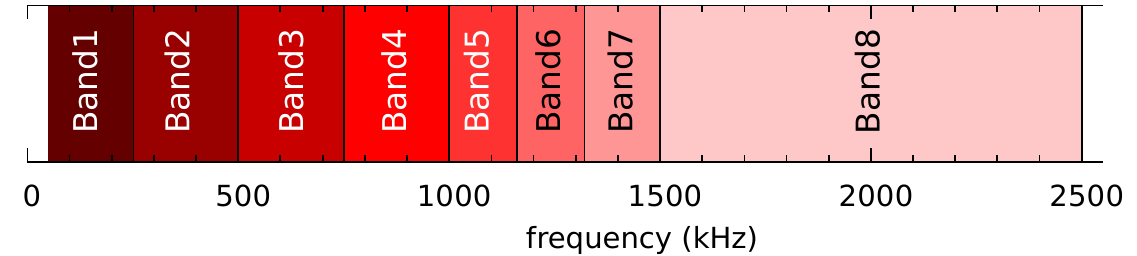
Figure 2. Scanning and generating C-scan images with the laser FF PE UPI system. The pulse laser beam of the laser FF PE UPI system can drive various ultrasound frequencies, and the LDV can divide the ultrasonic waves into several ultrasound bands. In this study, eight narrow bands were used. The 50–250, 250–500, 500–750, 750–1000, 1000–1160, 1160–1320, 1320—1500, and 1500–2500 kHz bands were called Band1, Band2, Band3, · · · , and Band8, respectively, as shown in Figure 3.